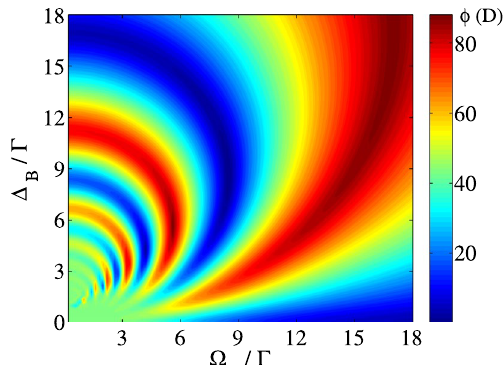
and Δ . The s B p